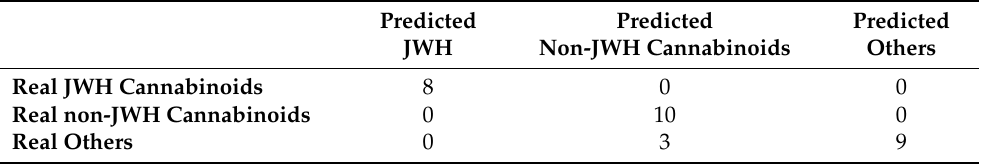
Table 5. Confusion matrix for the analyzed ANN—version 4: 27 (90.0%) tested compounds were correctly classified and 3 (10.0%) were misclassified.